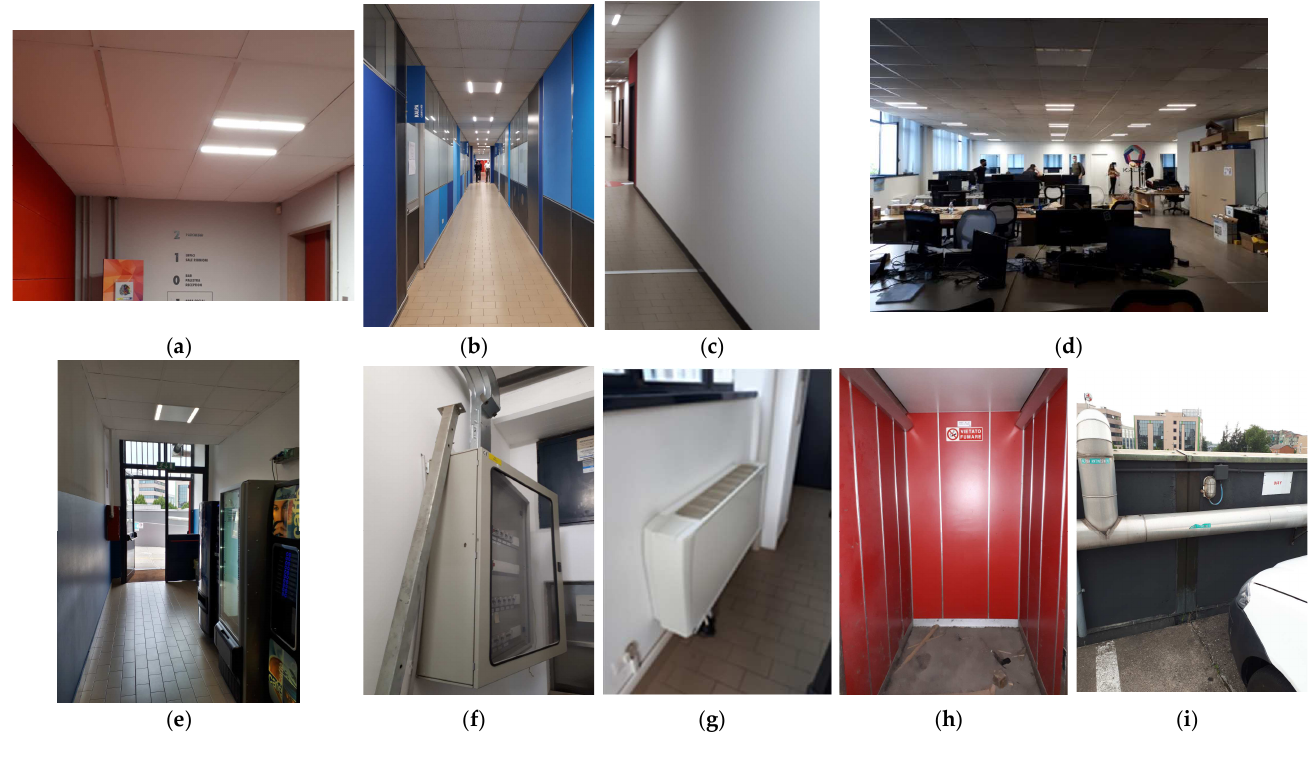
Figure 8. Examples of nonstructural elements of the case study building: ( a ) false ceilings with light- ing elements X; ( b ) aluminum-glass partitions; ( c ) drywall partitions; ( d ) office furniture; ( e ) vending machines; ( f ) electrical cabinets; ( g ) fan coils; ( h ) elevator; ( i ) piping system. Table 8. Median µ and logarithmic standard deviation β values of the lognormal fragility curves for ARCH nonstructural elements, along with the literature sources.